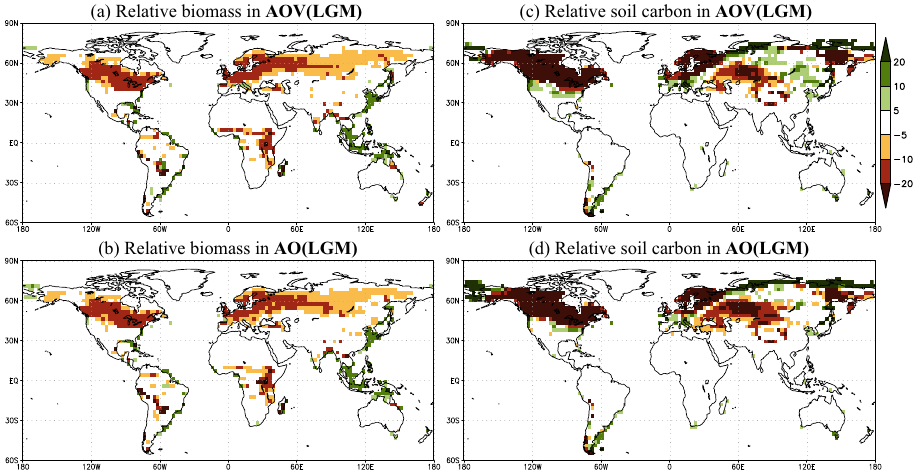
Fig. 7. Equilibrium absolute differences of biomass [kgm − 2 ] in (a) AOV(LGM) and (b) AO(LGM) with respect to AOV(PI). Equilibrium absolute differences of soil carbon [kgm − 2 ] in (c) AOV(LGM) and (d) AO(LGM) with respect to AOV(PI). Absolute values are shown in Appendix Figure A2.